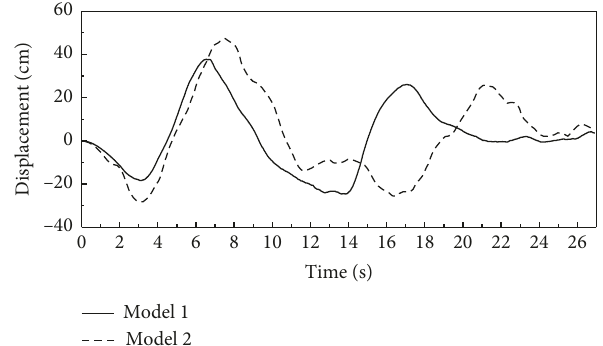
Figure 25: Contrastive analysis of horizontal displacement time- history curve for the top of